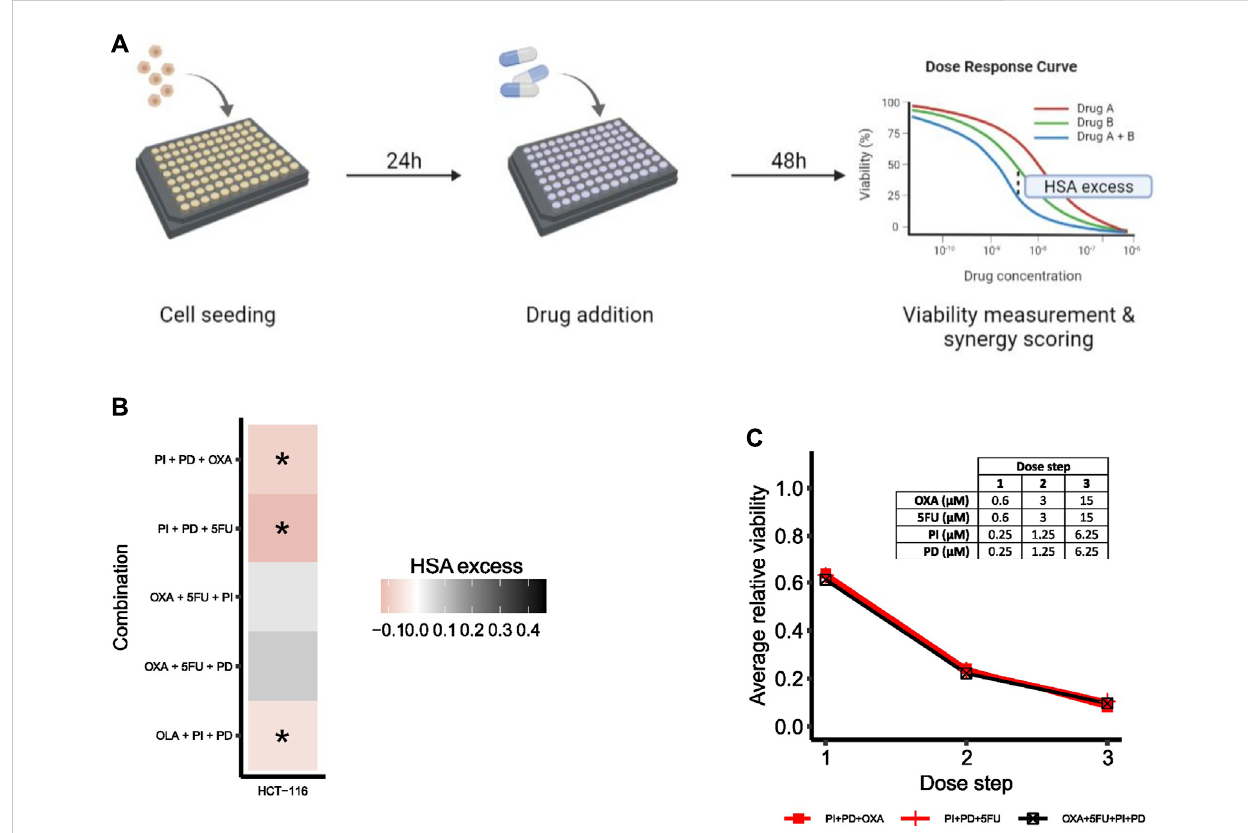
FIGURE 6 Drug synergy validations. (A) Simpli fi ed overview of the screening procedure with synergy scoring exempli fi ed for a second-order combination. (B) HeatmapofHSAexcess(viability-based)summedacrossthedose-raypercombination.Asterisks(*)indicatecombinationspredictedtobesynergisticby the computational model. (C) Viability dose-response curve for HCT-116 cells treated with the fourth-order combination OXA+5FU + PI + PD. The plot shows the fourth-order combination and the two most potent lower-order combinations (PI + PD + OXA, PI + PD+5FU). Concentrations per dose step are presented in the table. To make the plot clearer, error bars are not